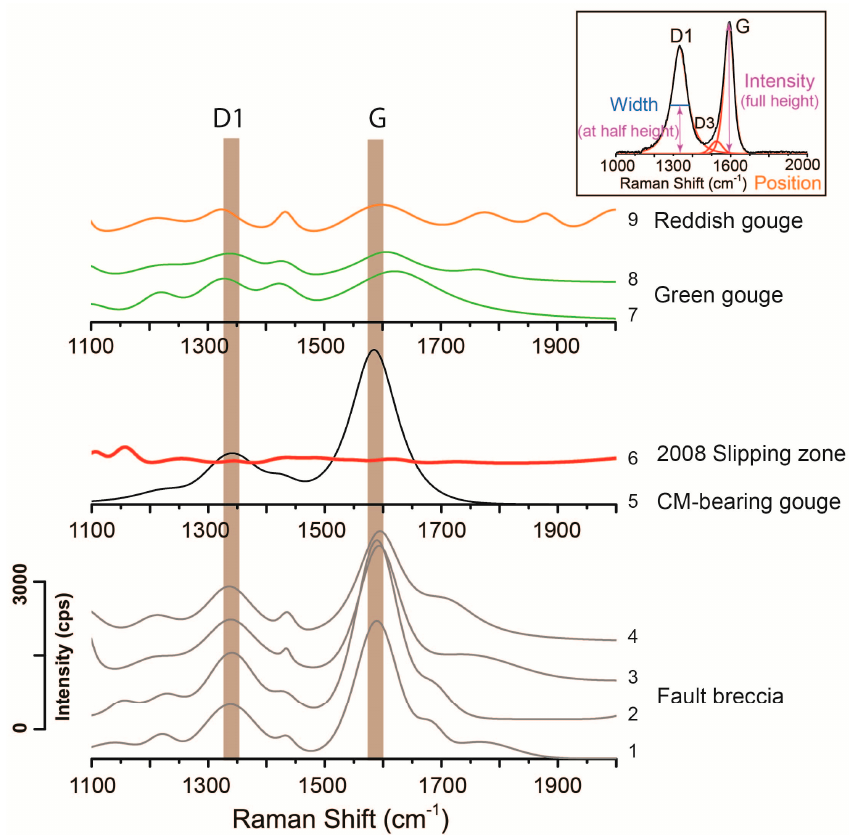
Figure 4. The representative first-order region of the Raman spectra for several fault components in the trench. The inset shows the criteria for defining the indicative parameters derived from the relevant spectrum decomposition (width, intensity, peak position, etc.).